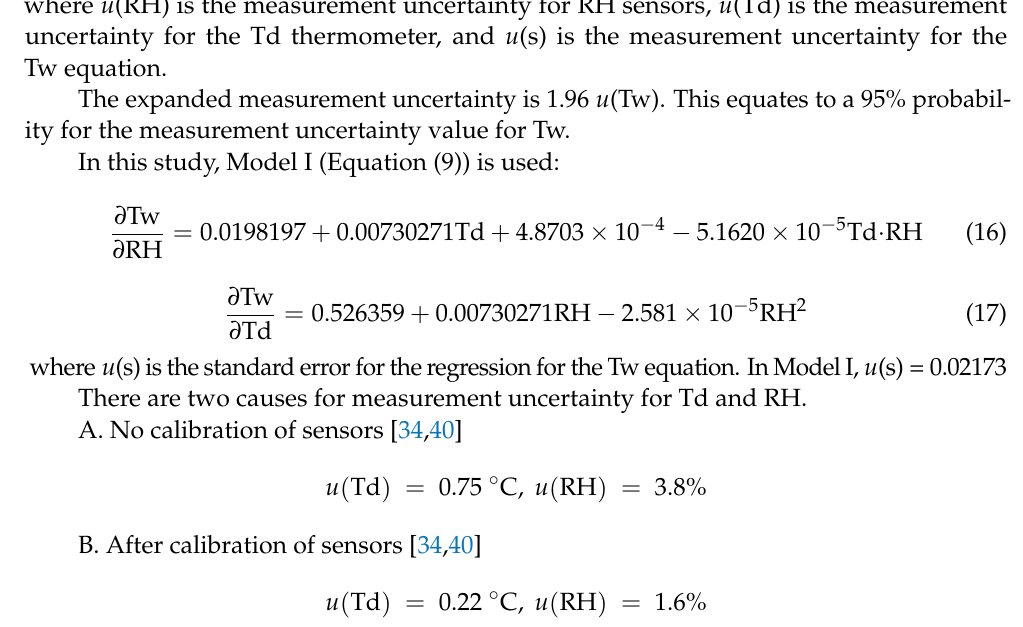
Figure 6. The relationship between Td and RH for a threshold of heat stress of 35 °C.